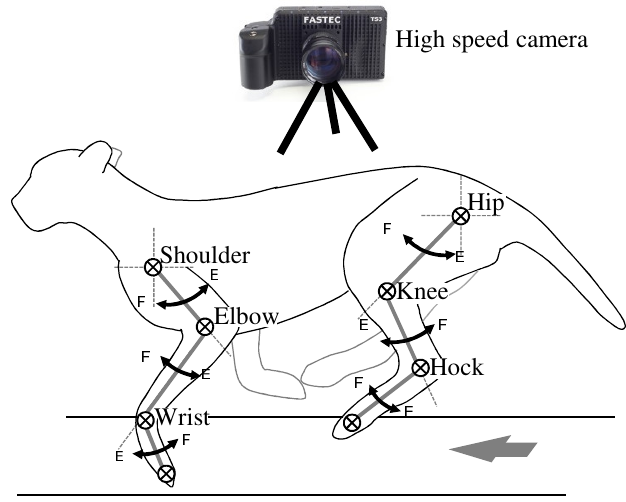
Figure 2. An experimental setting and the direction of joint-angle